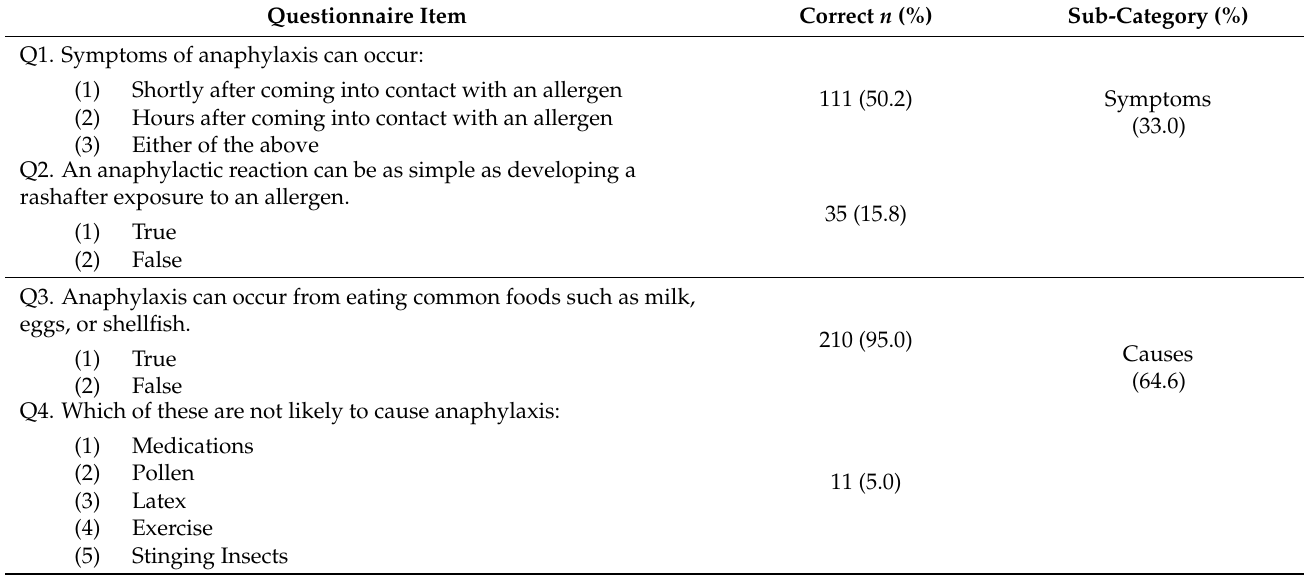
Table 3. The percentages of correct answers to the questionnaire ( n = 221). Questionnaire